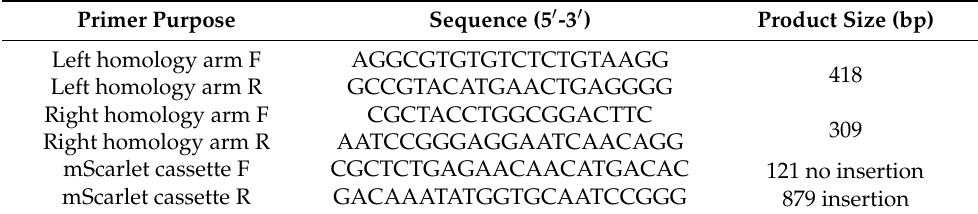
Table 1. Primers designed for insertion